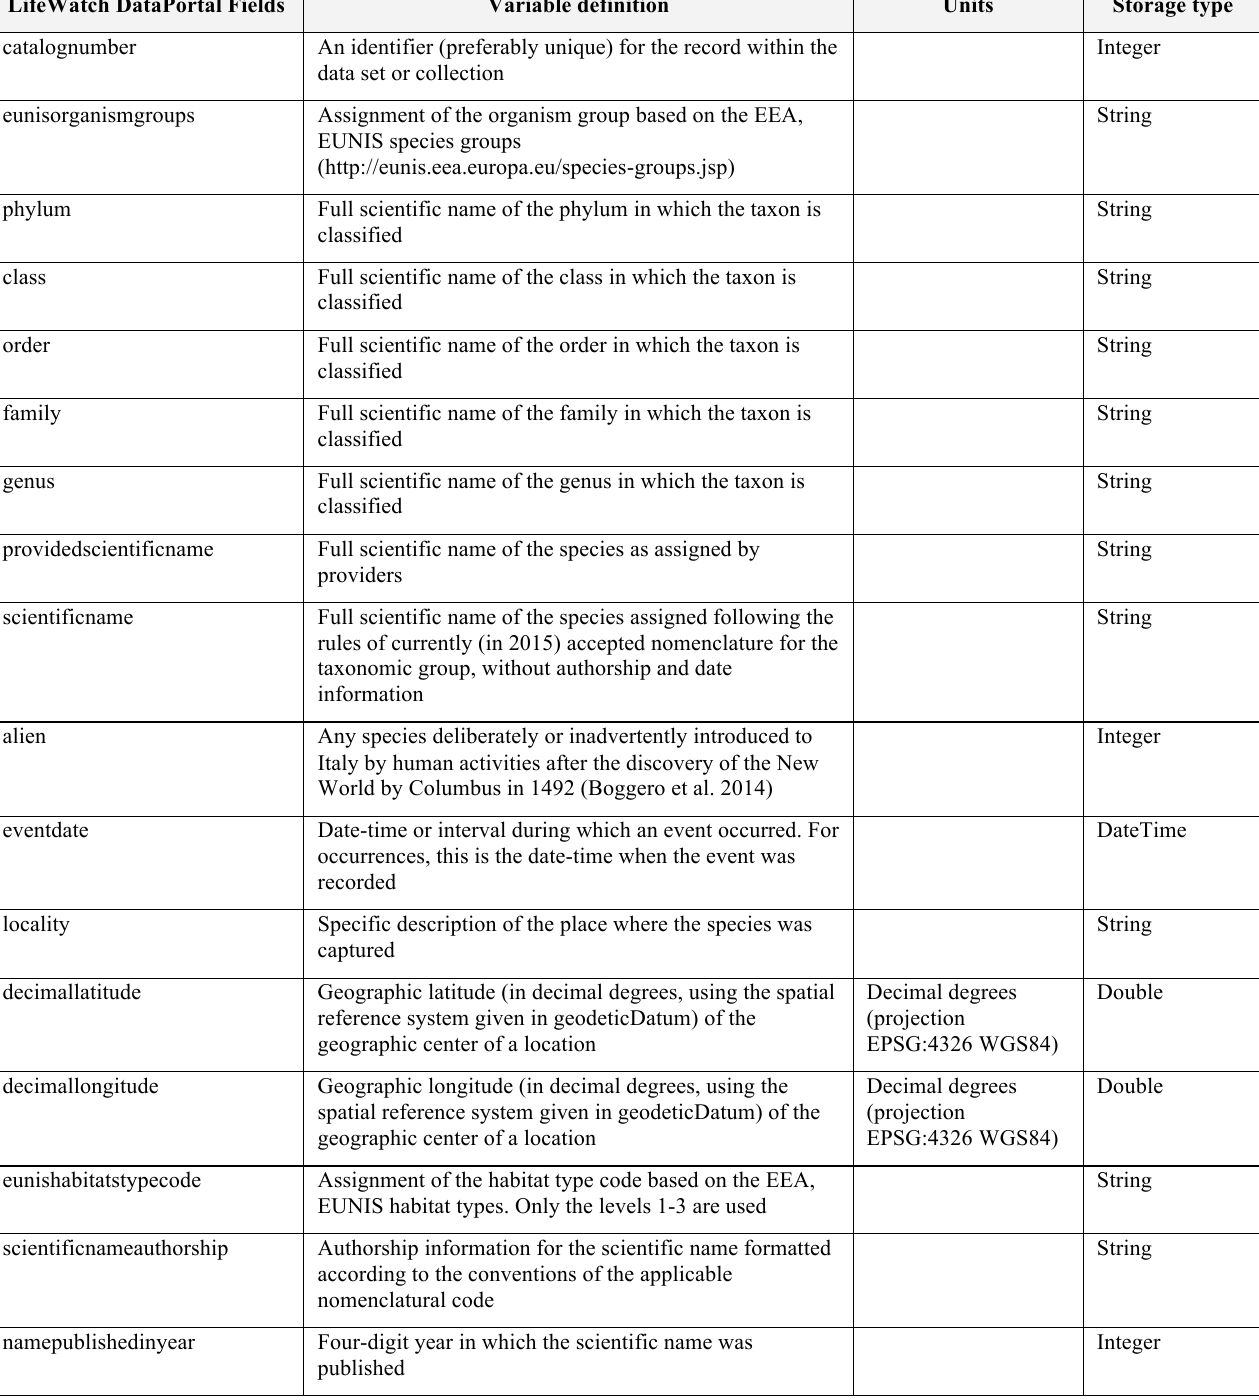
TABLE 1: Description of the dataset with specific information relative to definitions, units and